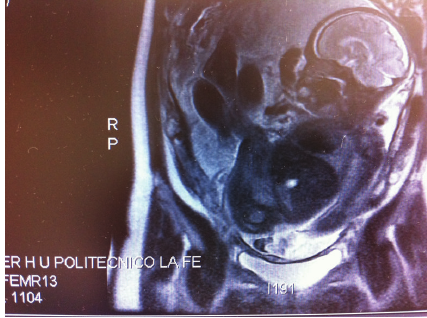
Figure 4: Male newborn with the tumor under the